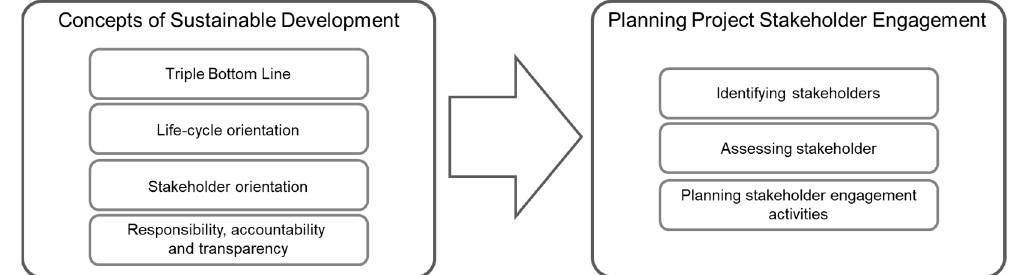
Figure 4. Conceptual framework of our analysis.